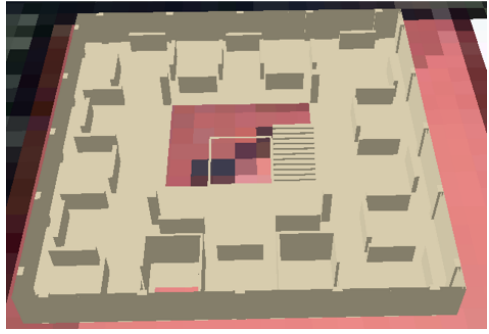
Figure 5. 3D model of the second floor.